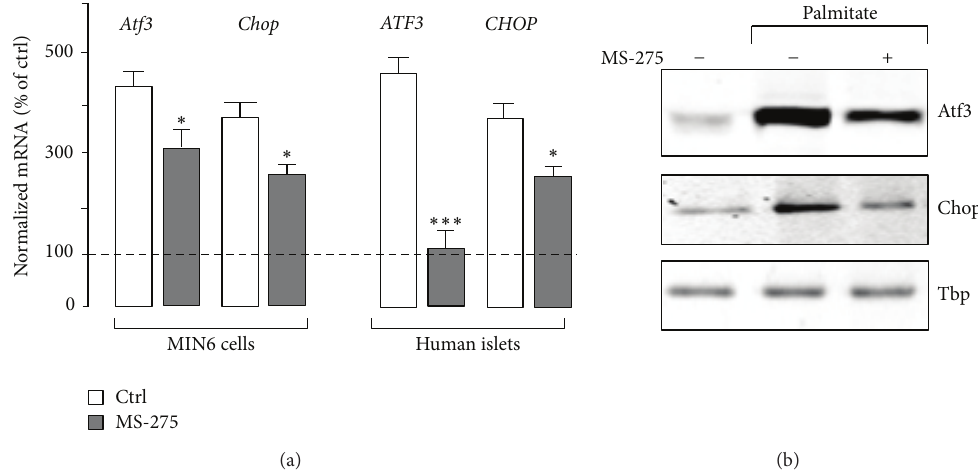
Figure 2: Effects of MS-275 on the expression the ER stress markers. (a) The mRNA of Atf3/ATF3 and Chop/CHOP was quantified by quantitative real-time PCR from MIN6 cells and isolated human islets cultured with 0.5 mM palmitate plus MS-275 ( grey bars ) or DMSO ( open bars ) for 48 hrs. The mRNA levels were normalized against the Rplp0/RPLP0 and the expression levels from cells cultured with BSA ( − ) were set to 100%. Data are the mean of ± SEM of 3 independent experiments ( ∗∗∗ 𝑃 < 0.001 ; ∗ 𝑃 < 0.05 ). (b) For western blotting analysis, nuclear proteins were prepared from cells cultured for 48 hrs with 0.5 mM palmitate plus DMSO ( − ) or 1 𝜇 M MS-275. Immunoblotting was done using the anti-Atf3, anti-Chop, and anti-Tbp as the control. The figure shows the result of a representative experiment out of three. The data are the mean ± SEM of 4 independent experiments ( ∗ 𝑃 < 0.05 ).